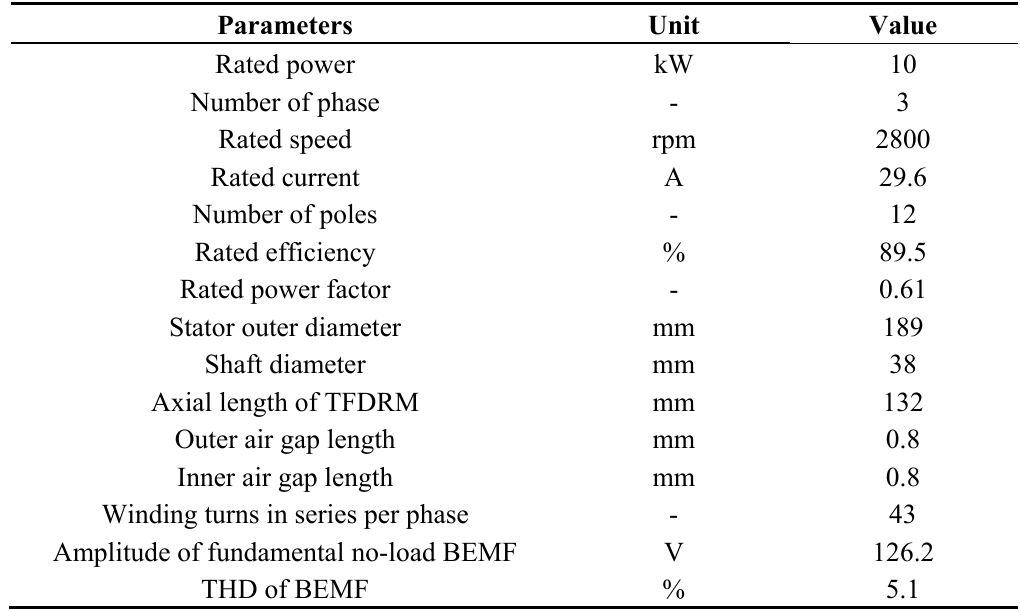
Table 3. Parameters of the